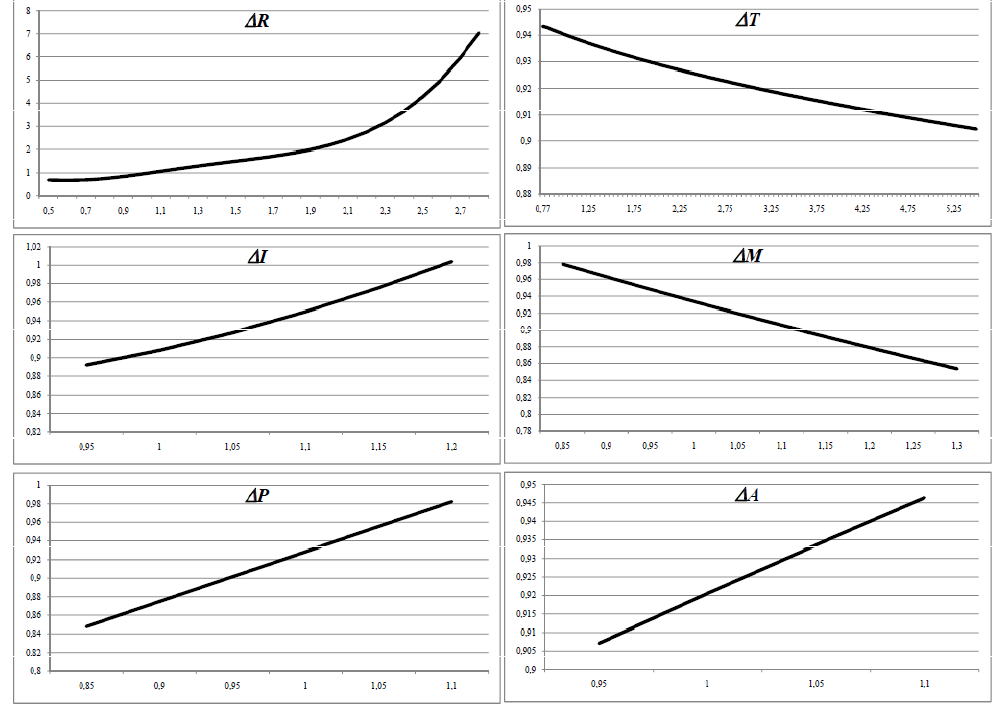
Figure 1. Evolutionary trend of the unit housing price variations depending on the variables of the model.